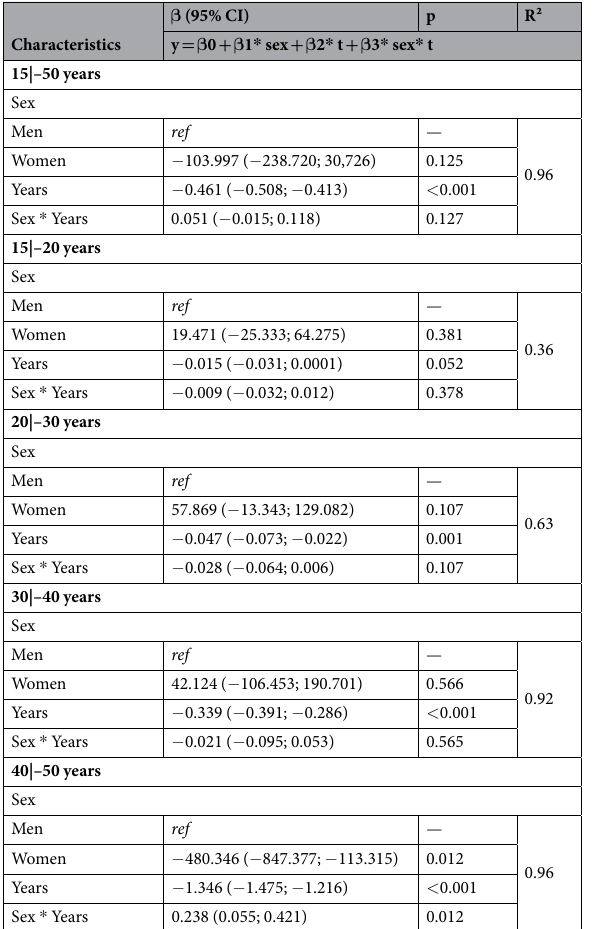
Table 3. Linear regression model with sex-years interaction of mortality related to stroke * in Brazilian men and women aged 15 to 49 years between 1997 and 2012. 95% CI: 95% confidence interval. * International Statistical Classification of Diseases and Related Health Problems–10th revision (ICD-10) codes: I60, I61, I63 and I64 19,20